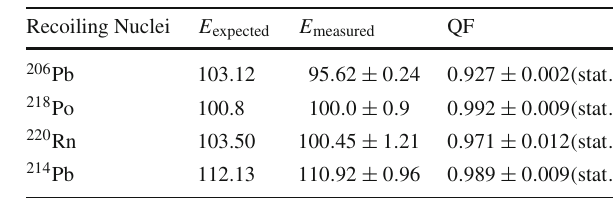
Table 3 Expected energy, measured energy obtained from fits, and resultingquenchingfactors(QFs)fortheselectedrecoilingnuclei.Only statistical uncertainties are shown in the